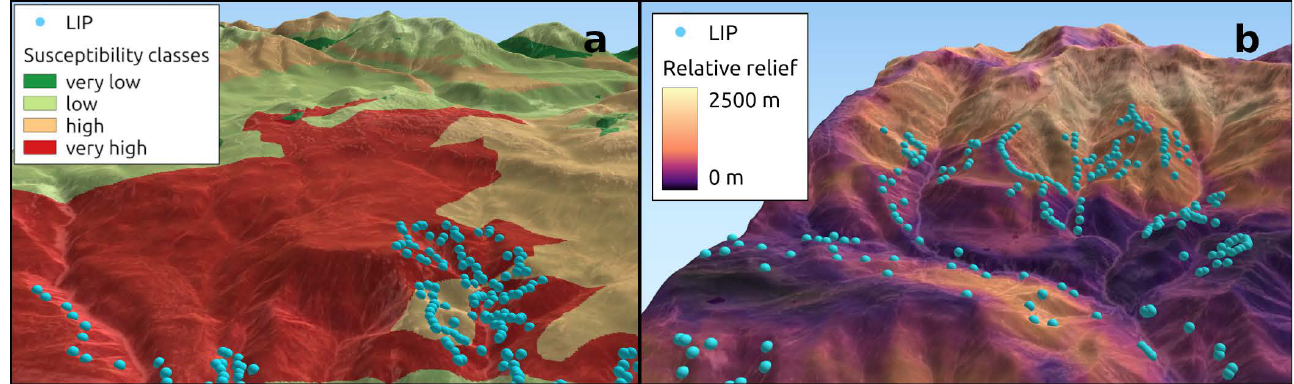
Figure 7. ( a ) 3D representations of the landslides distribution on the classified, area-based (Figure 6c) susceptibility map. ( b ) 3D representation of the landslides distribution and of the relative